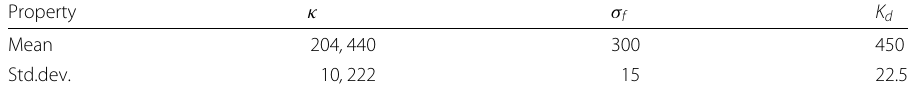
Table 2 Macro-scale statistics for elasto-damage constitutive model in [MPa] Property